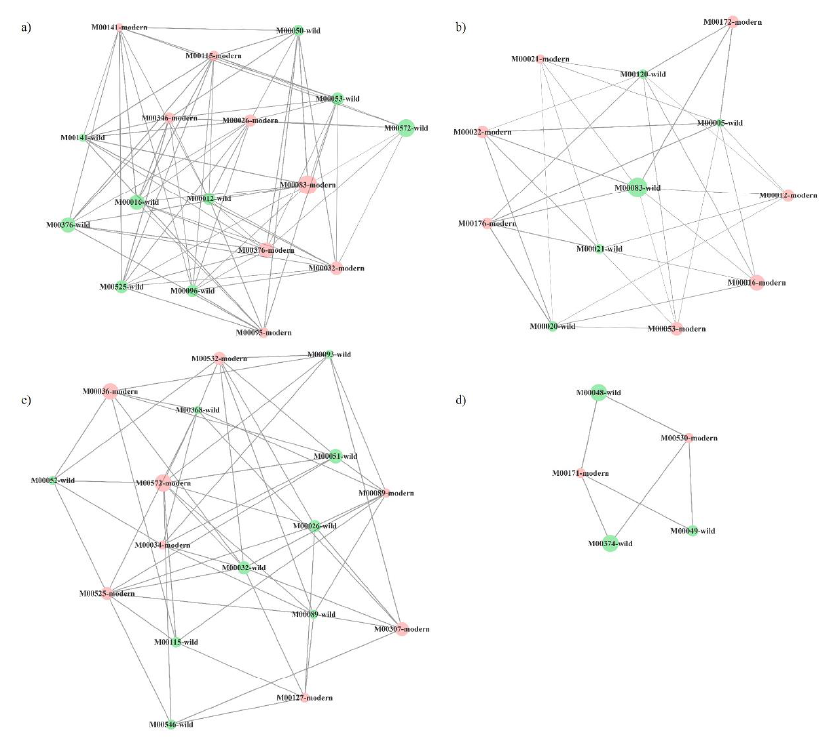
Figure 6. Four ( a – d ) most connected clusters in co-presence networks for the couple modern commercial cultivars (red):wild tomato relates species (green). Node sizes reflect average relative abundance of each KEGG module. The line thickness is proportional to the edge weight.